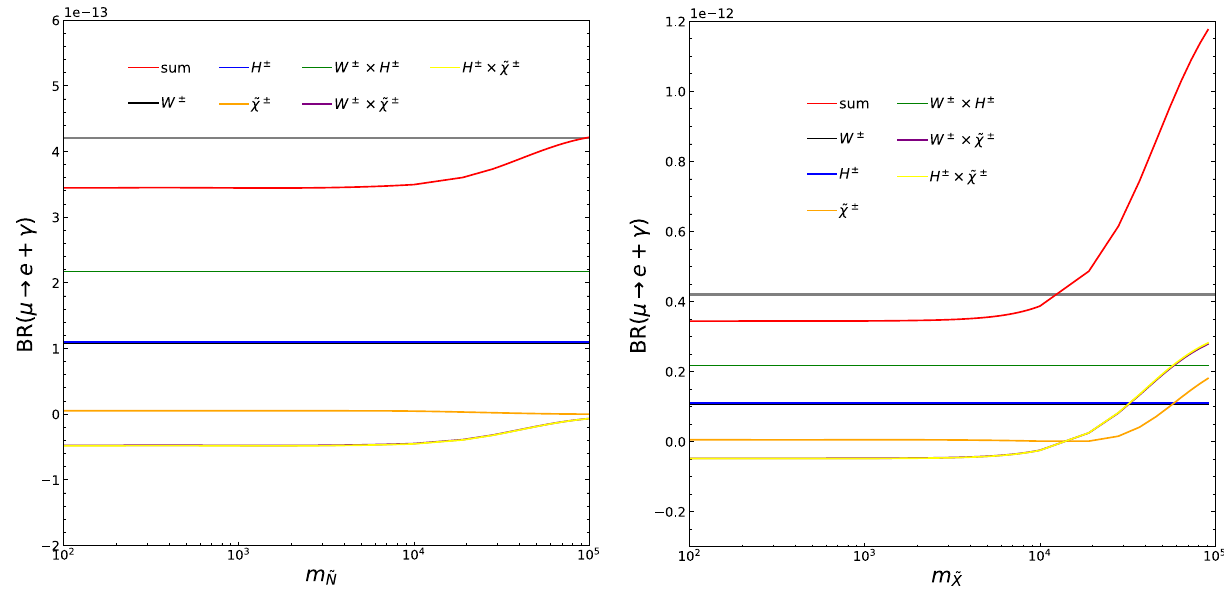
Fig. 8 Same as the left plot of Fig. 8, but m ˜